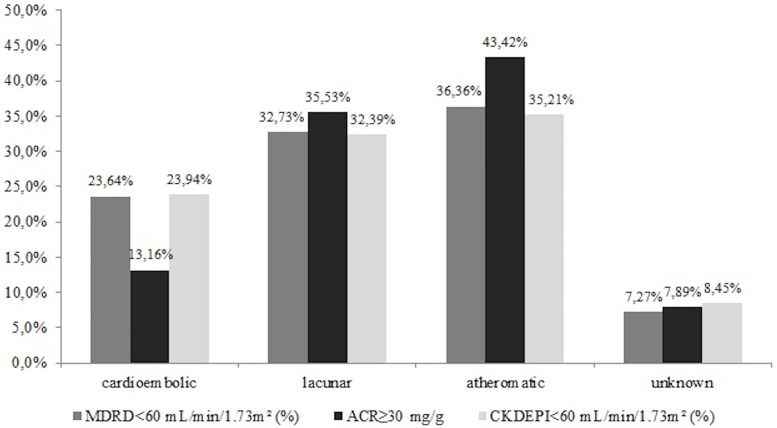
Frequency of diminished kidney function (eGFR < 60 mL/min/1.73m2) estimated by MDRD and CKD-EPI formulas and albuminuria measured as urine albumin to creatinine ratio (ACR) in survivors with ischemic stroke according to IS etiology.